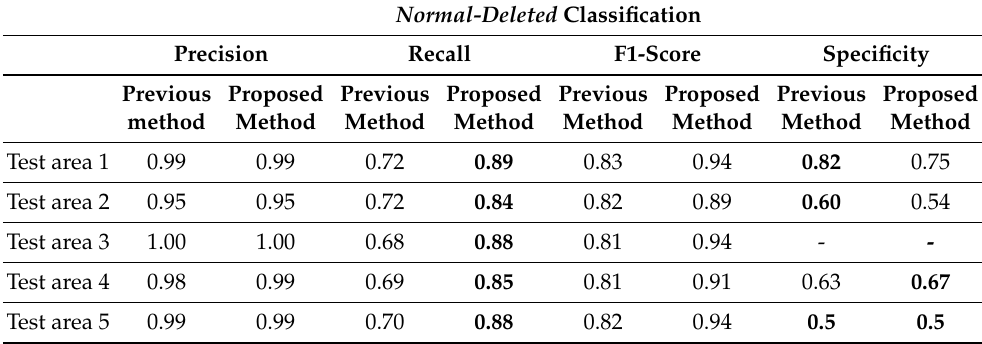
Table 3. Quantitative evaluation results of the Normal-Deleted classification for the previous and proposed methods.